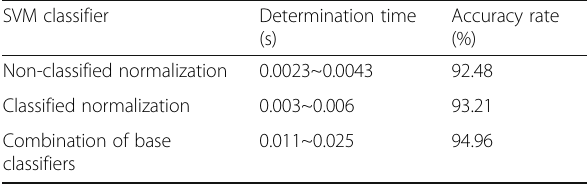
Table 2 Performance comparison of three SVM